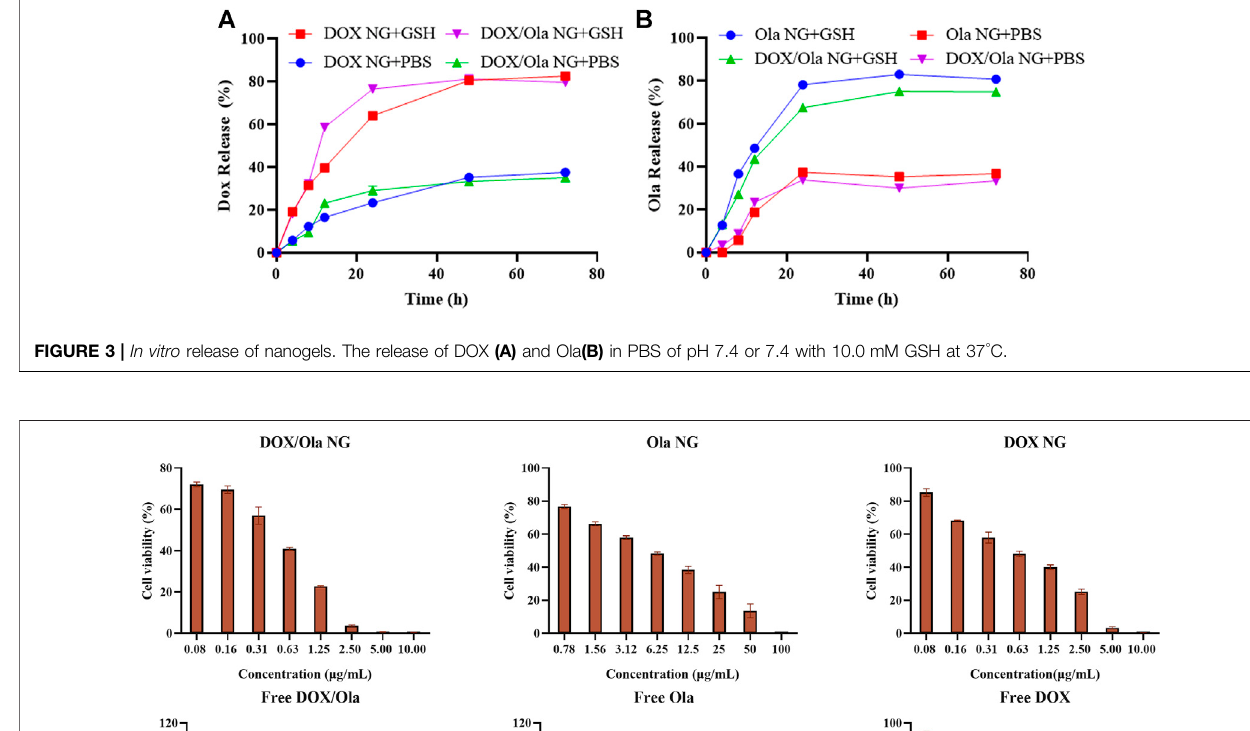
Frontiers in Bioengineering and Biotechnology |